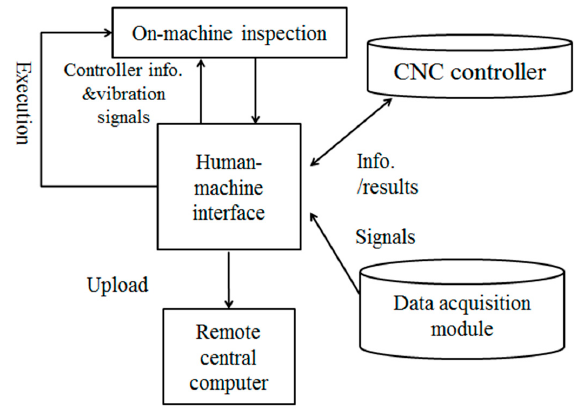
Figure 19. Flowchart of the function execution.